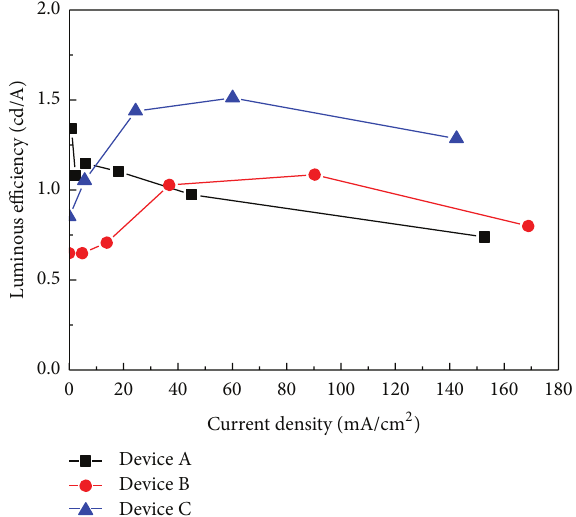
Figure 4: The normalized EL intensity spectra characteristics of the devices A–C at the current density of 10 mA/cm 2 .